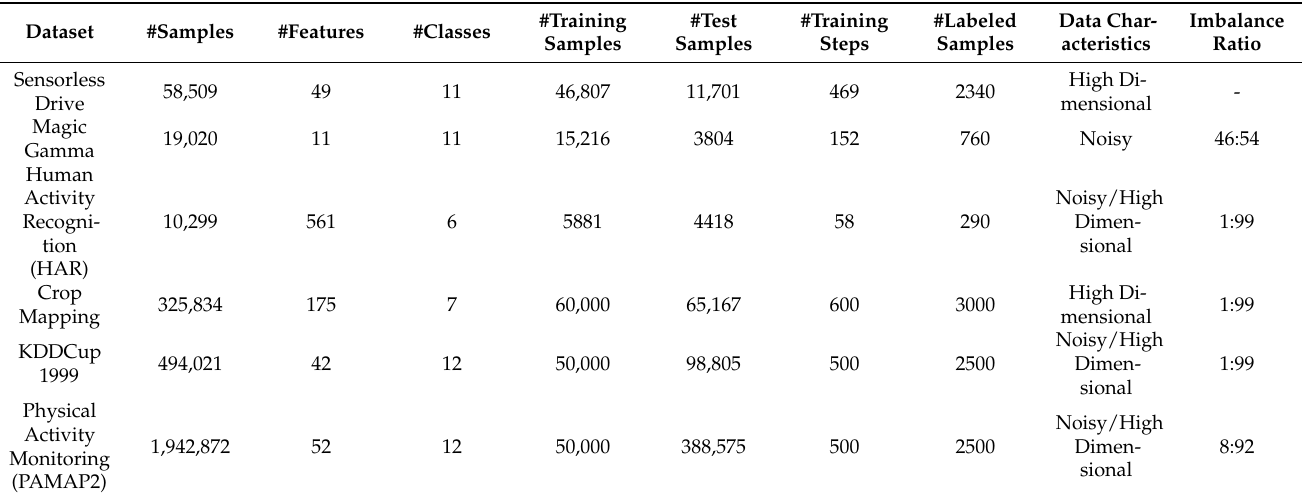
Table 4. Real-world datasets were used in this